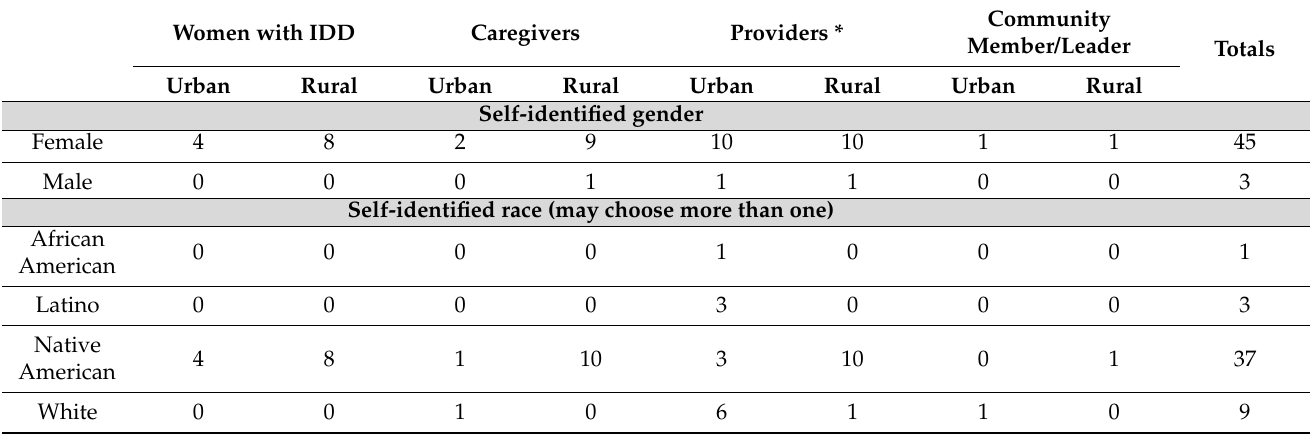
Table 1. Participant Demographics (N =